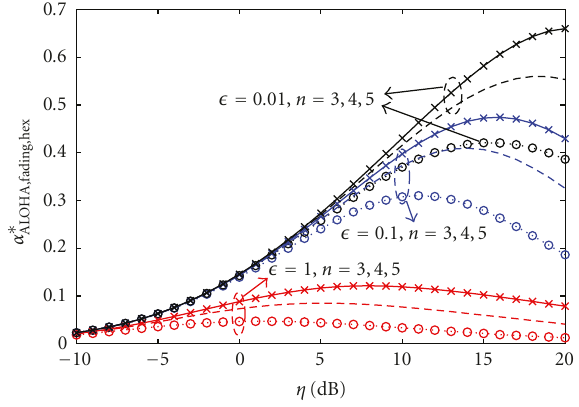
Figure 8: The p t -optimal α ALOHA,fading,hex in bits-meters/s/Hz/node versus η for the hexagonal topology under SNR 0 = 30dB and ρ = 1.